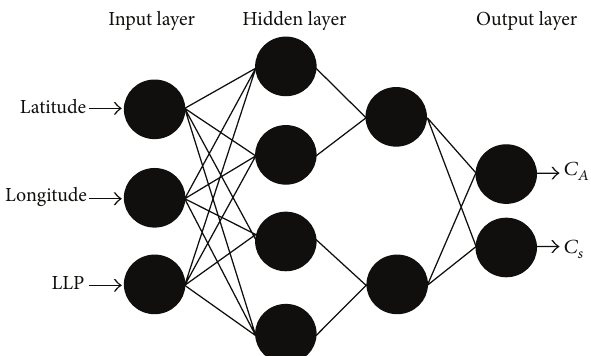
Figure 1: Topology of the GRNN used to predict the optimum size of a